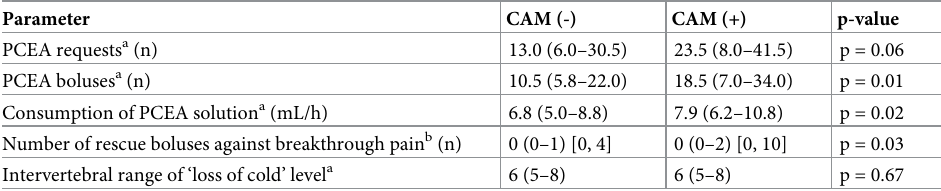
Table 5. Secondary outcomes; quality of epidural labor